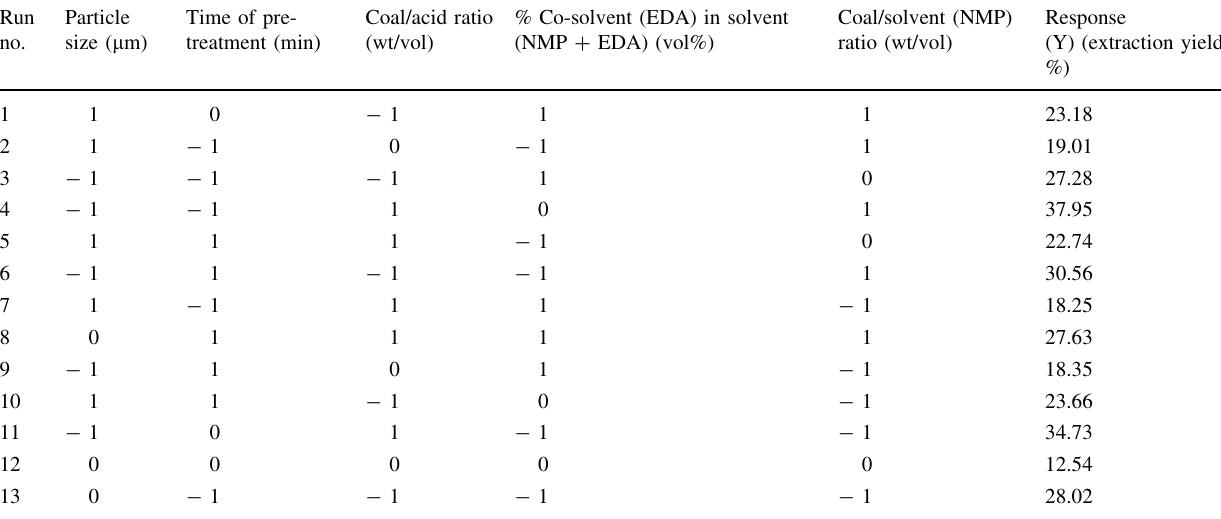
Table 4 13 Run definitive screening design (DSD) for optimization of five parameters Run no.